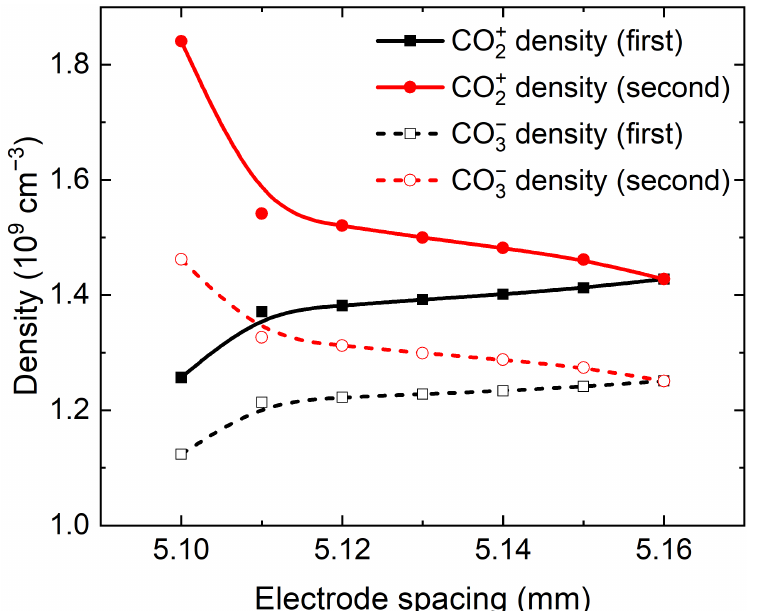
Figure 12. The residual ions density in the sheath region at the beginning of the negative discharge for two consecutive voltage periods as a function of gap width in the evolution from RP2 discharge to RP1